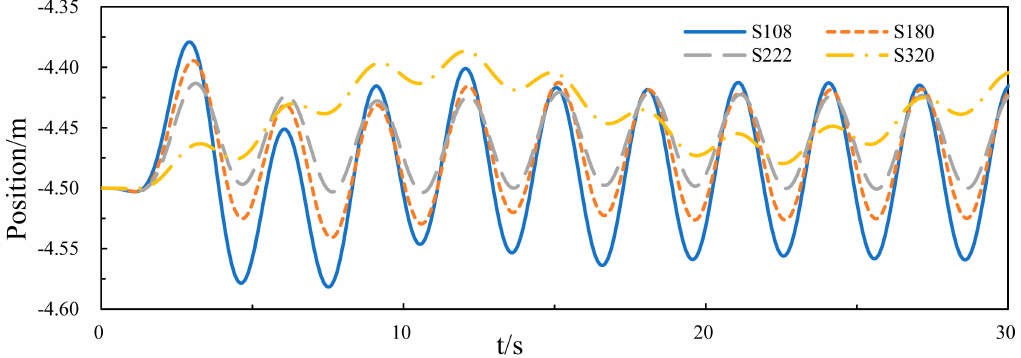
Figure 10. Oscillation curve of the central platform.